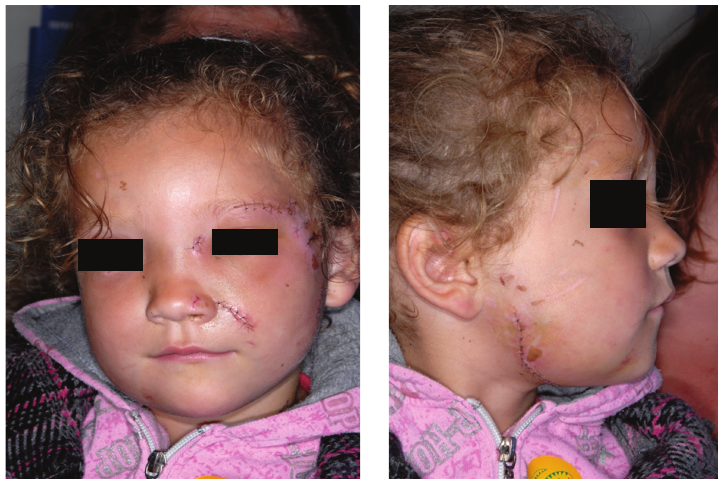
Figure 2: The extent of the soft-tissue injuries sustained from the dog-bite